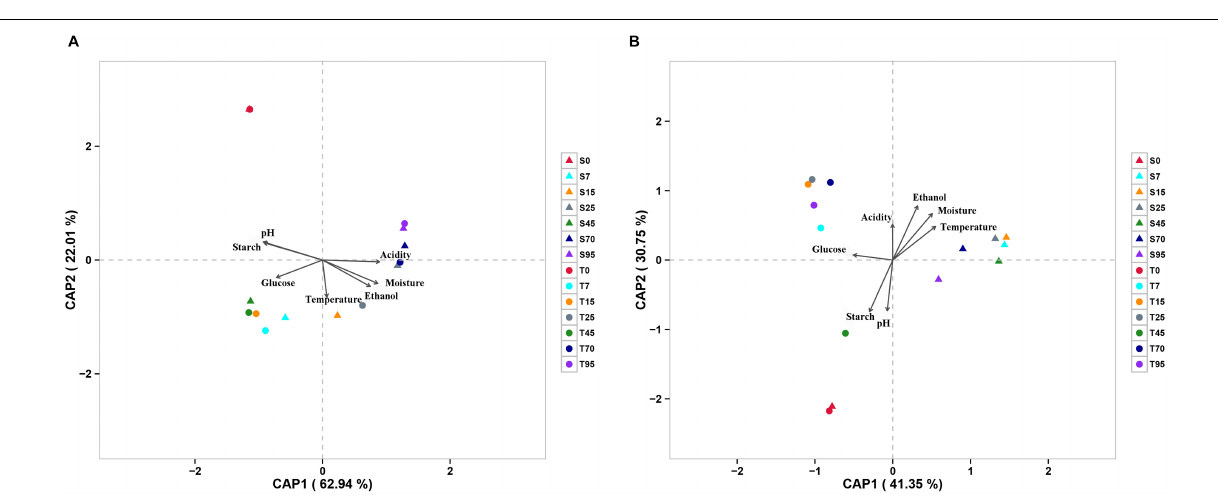
FIGURE 4 | Distance-based redundancy analysis (db-RDA) of bacterial (A) and fungal (B) community structures as obtained by Illumina HiSeq sequencing and measurable environmental